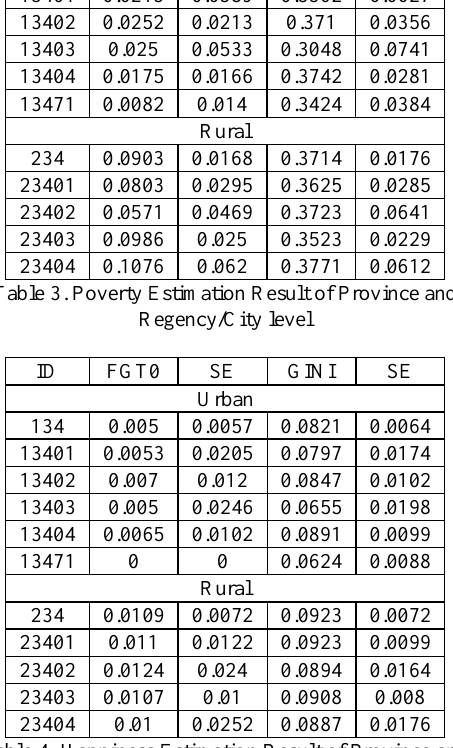
Table 4. Happiness Estimation Result of Province and Regency/City